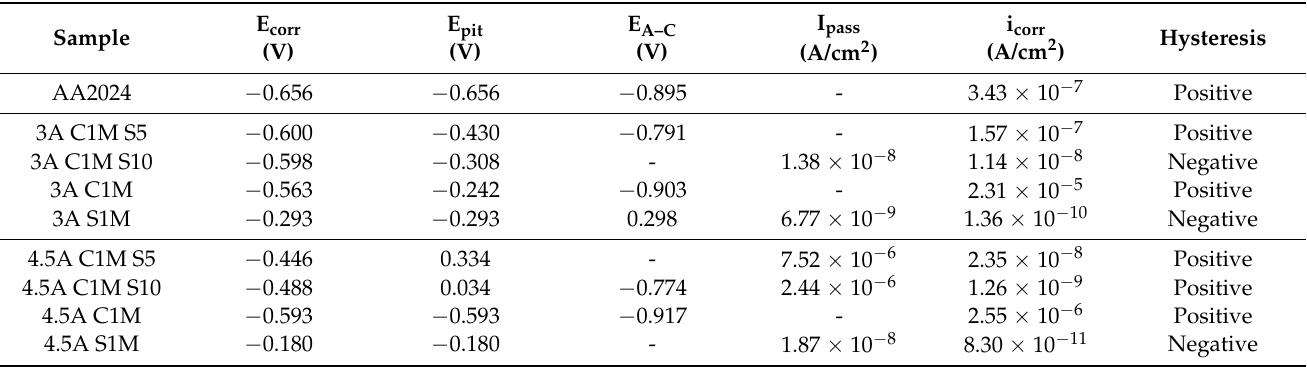
Table 2. Electrochemical parameters using CPP of AA2024 and different anodized samples and immersed in NaCl